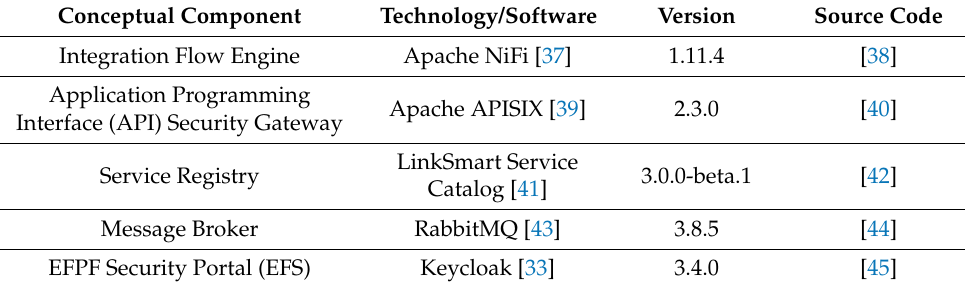
Table 3. Technologies used to realise the conceptual components of the Data Spine.